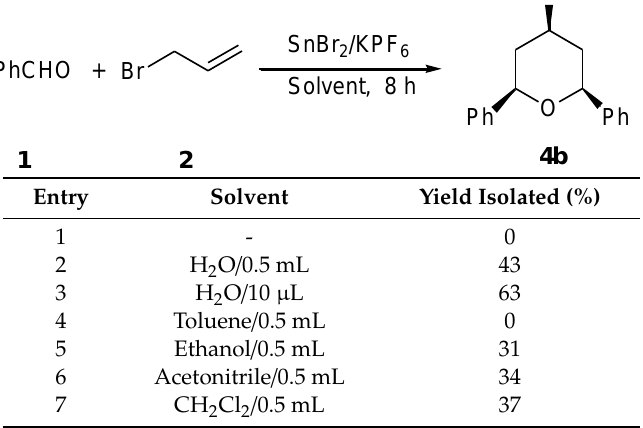
Table 5. Reaction of benzaldehyde (1) with allyl bromide (2) promoted by KPF 6.